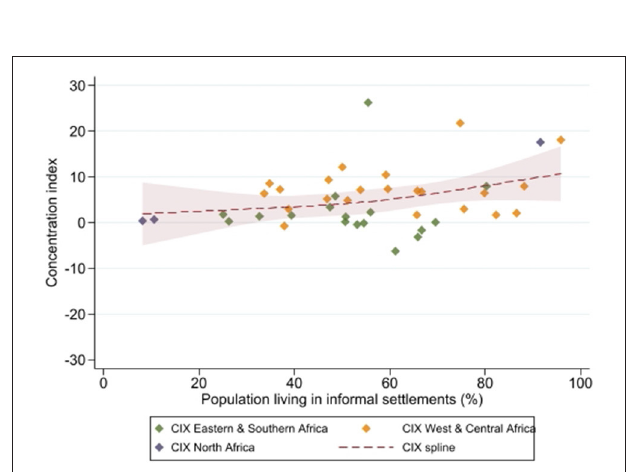
FIGURE 3 | Cubic spline model showing the relationship between the concentration index and the proportion of the population living in informal settlements for each